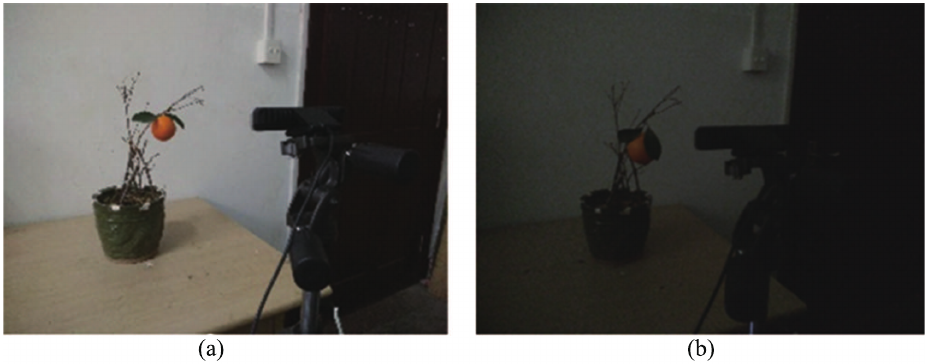
Figure 14. Experimental scene of citrus fruit and leaf: ( a ) light environment; ( b ) dark